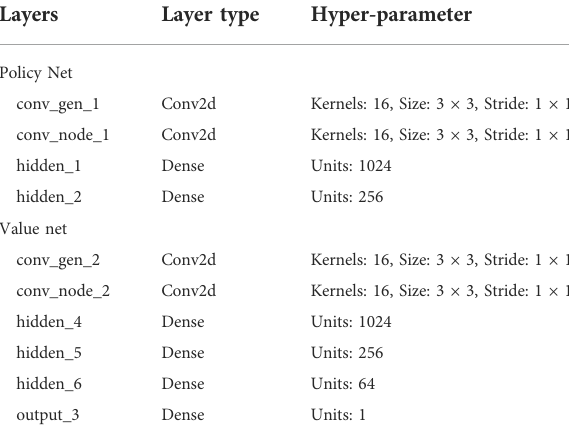
TABLE 2 The hyperparameters of the policy network and the value network. Layers